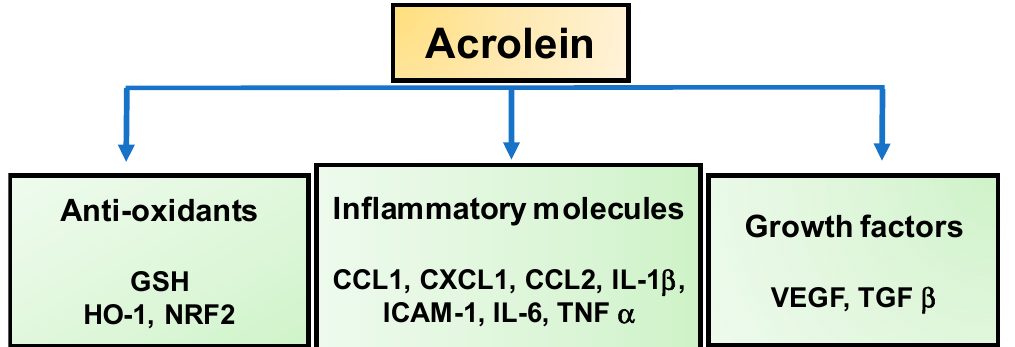
Figure 3. The molecular targets of acrolein in diabetic retinopathy (DR) development. GSH, glutathione; HO-1, heme oxygenase-1, Nrf2, nuclear factor erythroid 2-related factor 2; CCL1, chemokine (C-C motif) ligand 1; CXCL1, C-X-C motif chemokine ligand 1; CCL2, chemokine (C-C motif) ligand 2; ICAM-1, intercellular adhesion molecule 1; IL-6, interleukin 6; IL-1 β , interleukin 1 beta, TNF- α , tumor necrosis factor alpha; VEGF, vascular endothelial growth factor and TGF- β , transforming growth factor